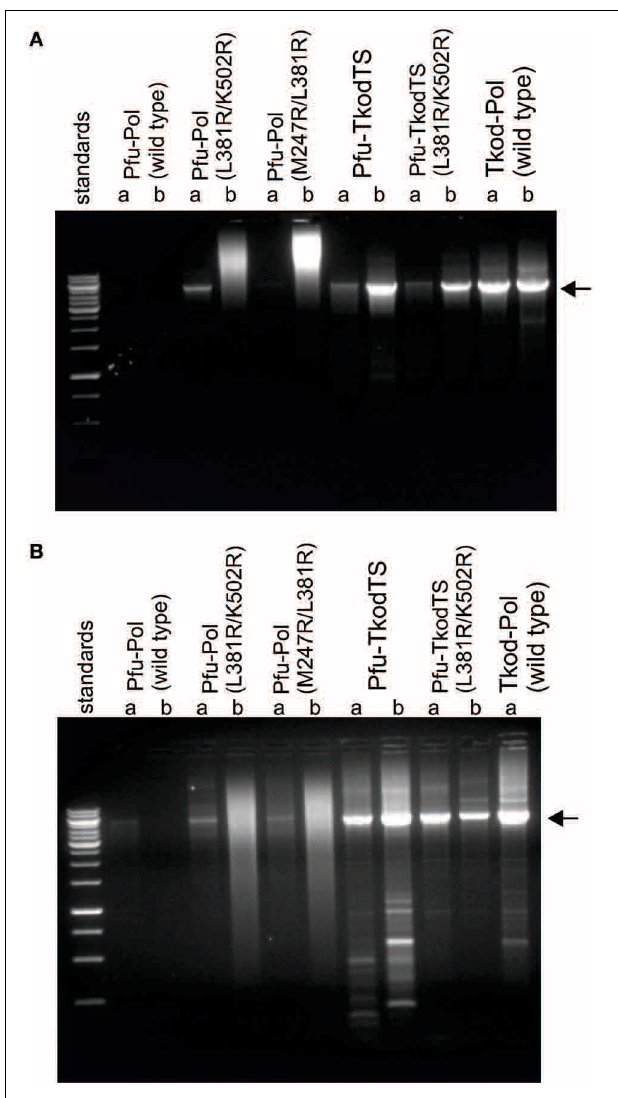
FIGURE 5 | PCR amplification of ∼ 5kb of DNA in pET17b[Pfu-Pol] by polymerase variants. Reactions were carried out using the polymerase variants indicated ( a = 20 nM; b = 100 nM) in two buffer systems ( A = Tris-HCl pH 8; B = Bicine-NaOH pH 9). Analysis was by 1% agarose gel electrophoresis with ethidium bromide staining. The standards comprise a 1kb ladder with the more intense bands at 1, 3, and 6kB. The expected PCR product ( ∼ 5kb) is indicated with the